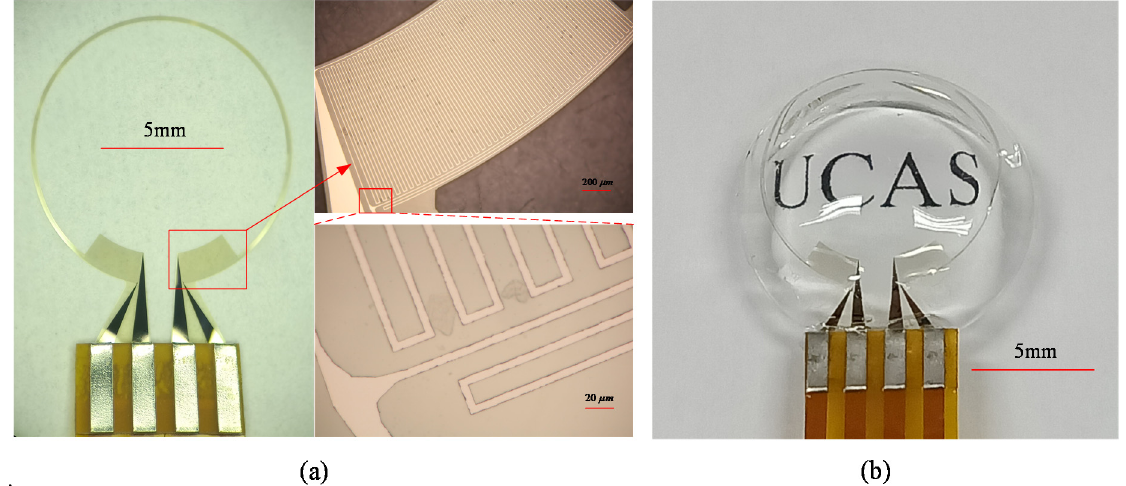
Figure 3. Physical image of ( a ) strain gauge and ( b ) contact lens sensor.